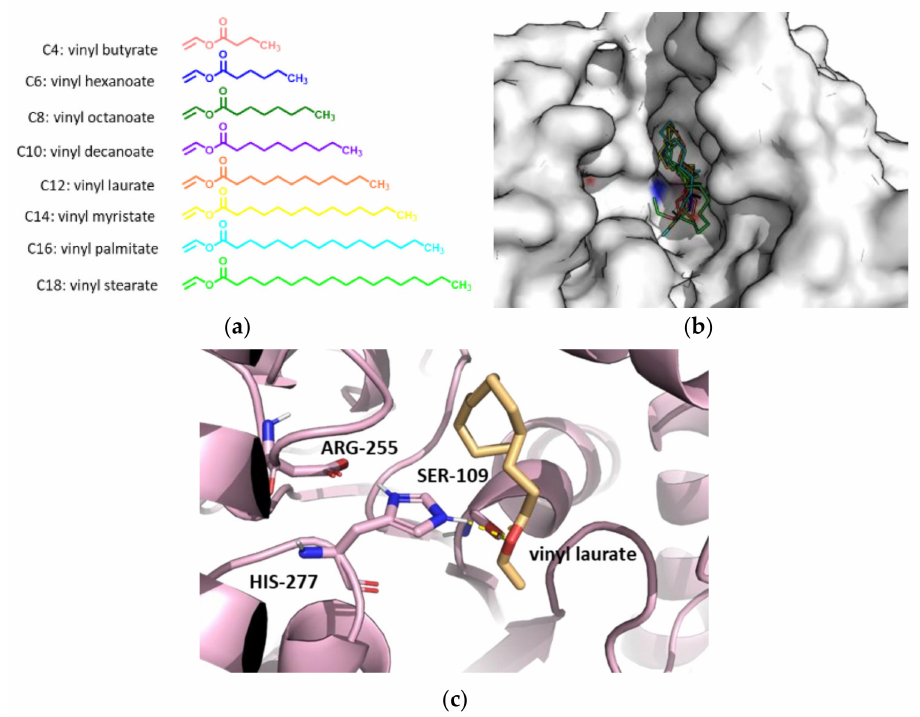
Figure 12. ( a ) Vinyl ester structures of different chain length; ( b ) vinyl esters docking into the cavity of PSL (protein is drawn in white surface and the ligands as coloured sticks); ( c ) vinyl laurate docking (C12) into the cavity of PSL (protein is depicted as pink cartoon, catalytic residues as pink sticks and vinyl laurate as orange sticks, and interactions are drawn as yellow dashes